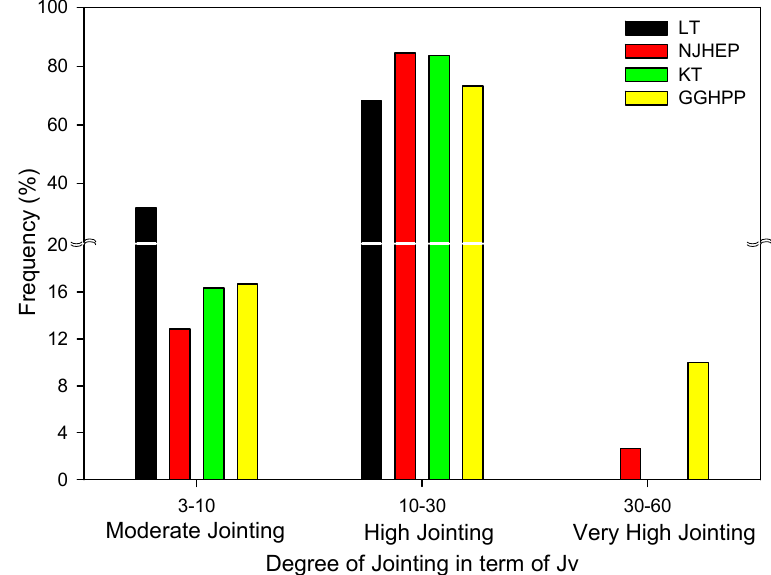
Figure 8. Classification of J v based on the degree of jointing [47].